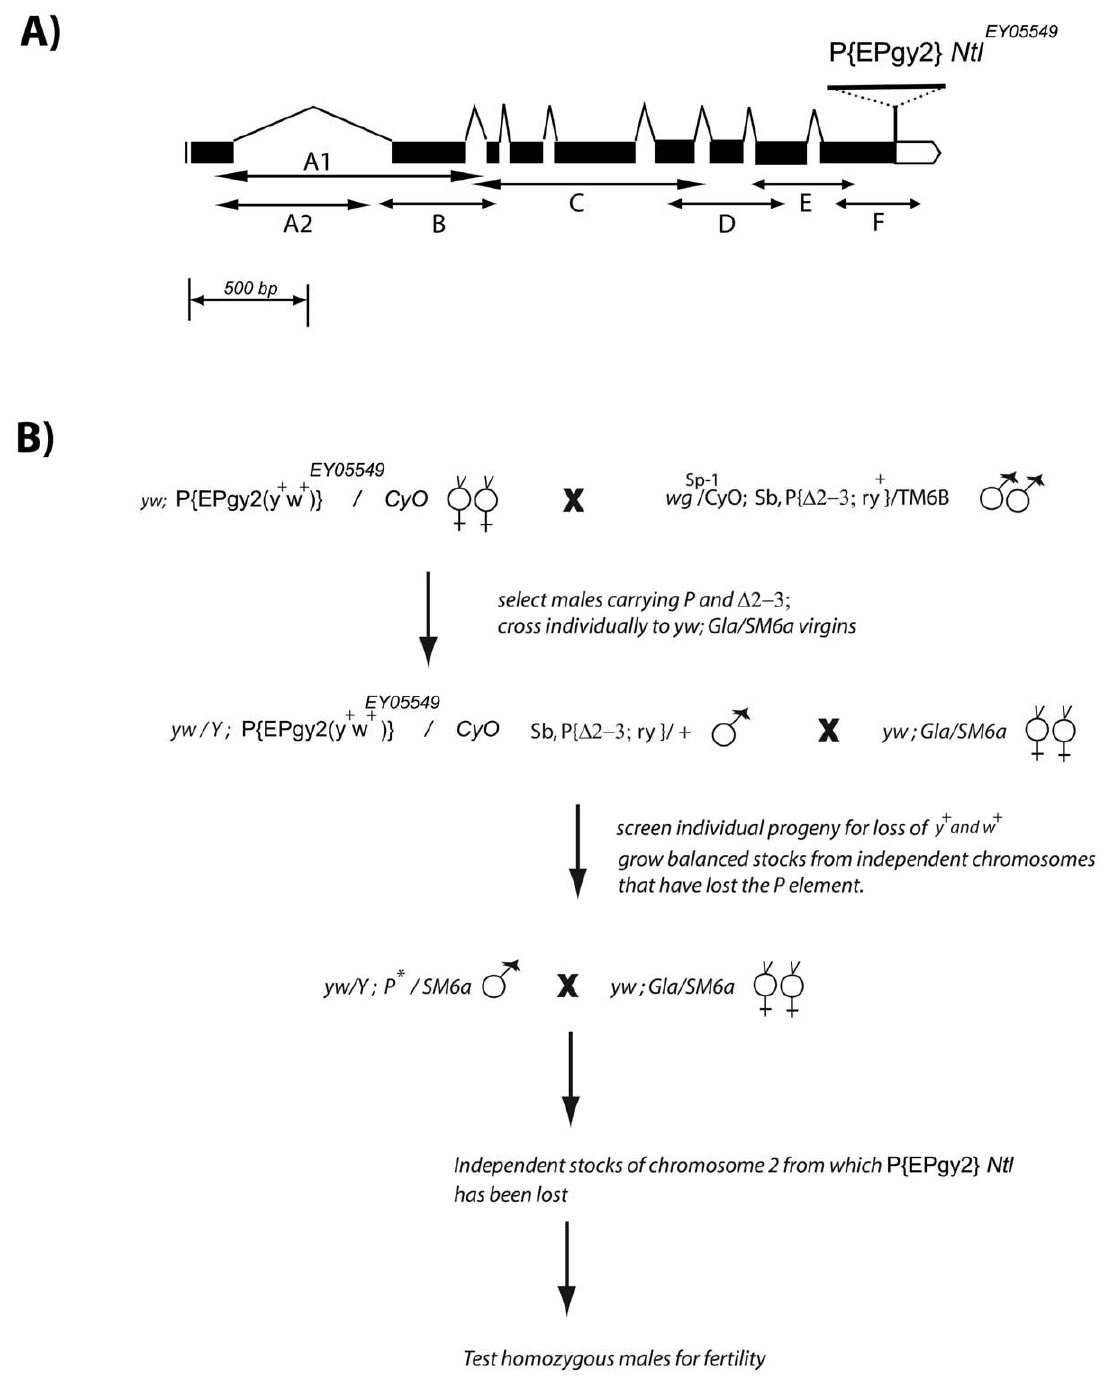
Figure 2. Generation of Ntl mutants. A) Ntl transcript/CDR from 28C on the left arm of chromosome 2. P element is inserted at the very end of the protein coding region. B) Scheme for generation of Ntl deletion mutations by imprecise excision of the P element.